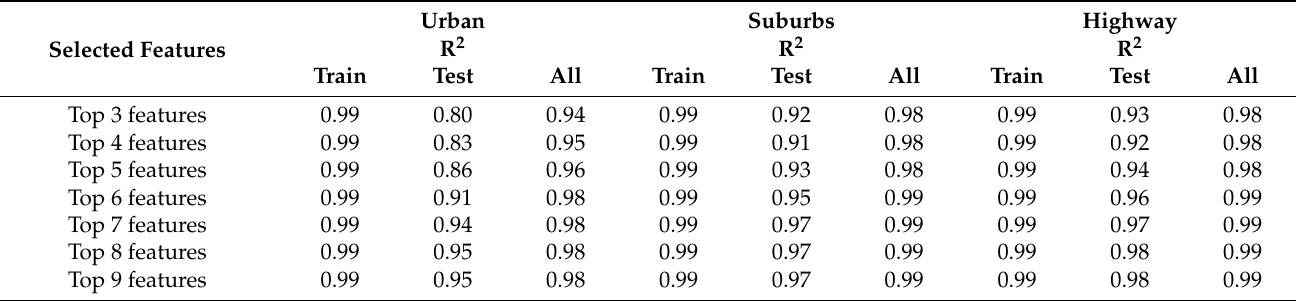
Table 10. Performance R statistics results of CO 2